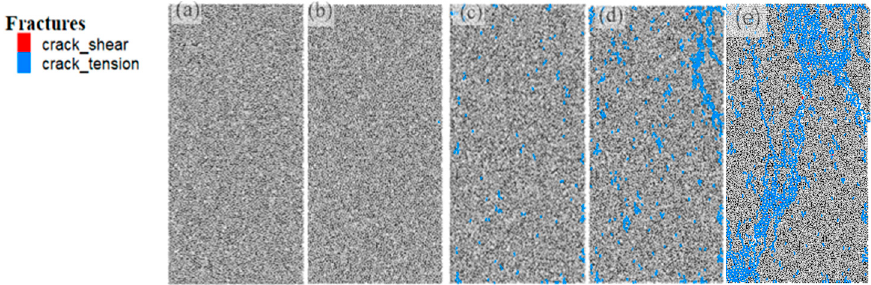
Figure 8. Crack propagation diagram of the numerical experiment at different stress levels ( a ) 0.1 σ c ; ( b ) 0.4 σ c ; ( c ) 0.8 σ c ; ( d ) σ c ; ( e ) 0.1 σ c .